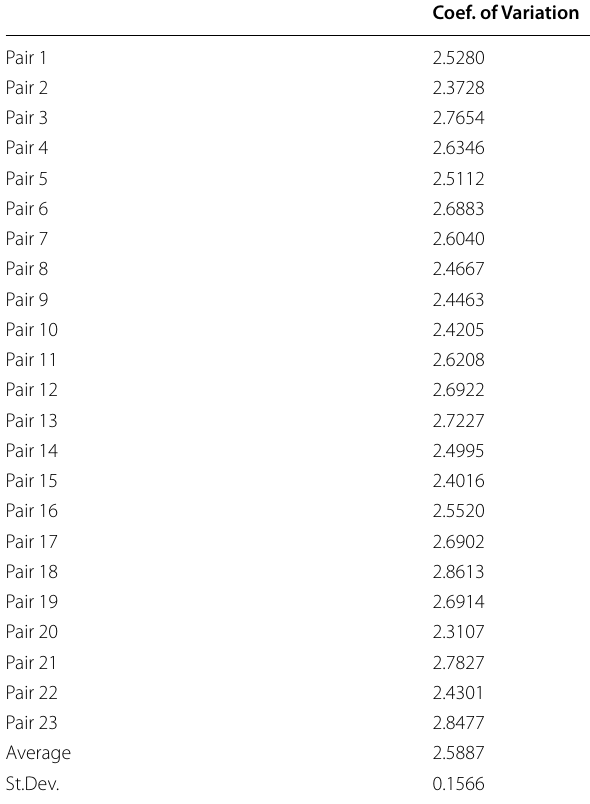
Table 6 Measured Coefficient of Variation for each kneading- pestle explicit pair